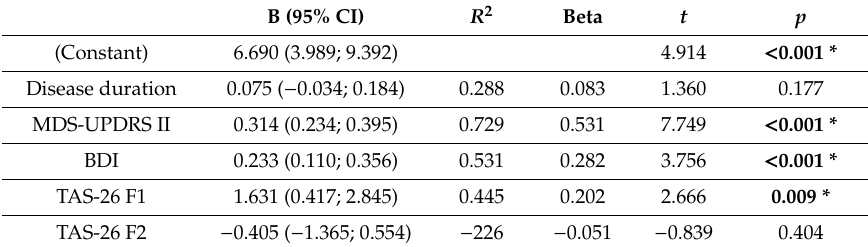
Table 4. Multiple regression analysis of factors influencing quality of life of PD patients measured by the disease specific assessment tool PDQ-8 ( n = 104).